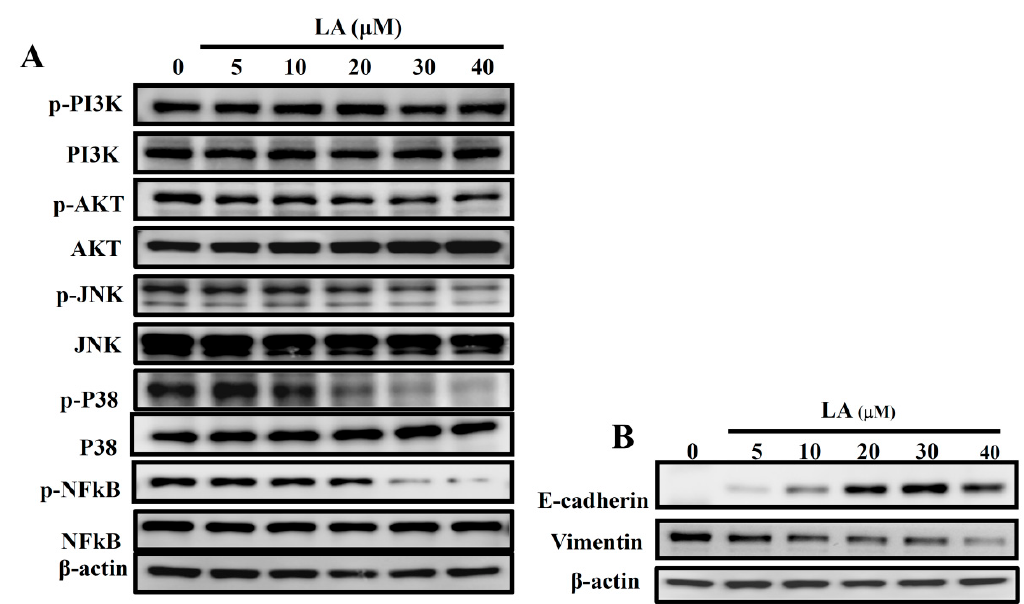
Figure 5. Effects of licochalcone A (LA) on AKT and the MAPK signal pathways. ( A ) Effect of varying concentrations (0–40 µ M) of licochalcone A (LA) on the phosphorylation of PI3K, AKT, p38, JNK, and NF- κ B. ( B ) E-cadherin and vimentin were also assessed by Western blot, with β -actin as an internal control.